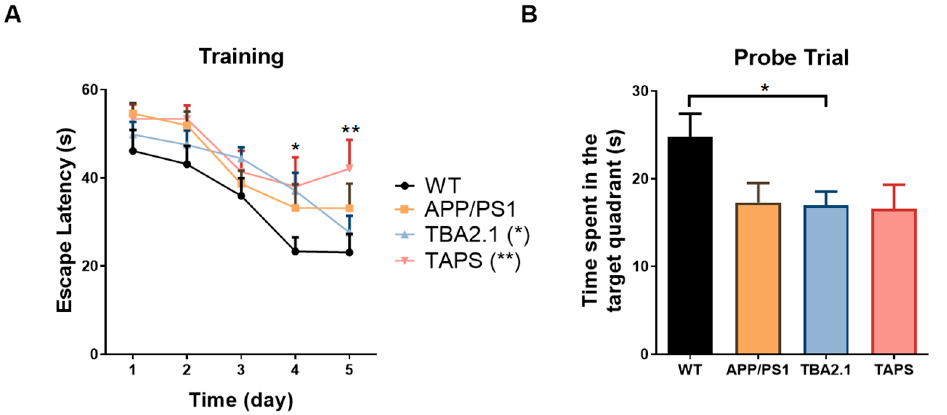
Figure 10. Performance in the Morris water maze with 20 months of age. In the training trials ( A ), the TAPS mice ( n = 6) took longer to find the hidden platform compared to the wild-type mice (WT; n = 11) on the last day (** p = 0.0087), as well as TBA2.1 ( n = 12) on the fourth day (* p = 0.0241), indicating a spatial learning deficit. In the probe trial ( B ), the TBA2.1 mice spent significantly less time in the target quadrant compared to WT mice (* p = 0.0319), while APP/PS1 ( n = 8) and TAPS mice showed a non-significant trend towards reduced memory retrieval as they spent less time in the target quadrant than the WT mice. For statistical analysis, two-way and one-way ANOVA with Dunnett´s post-hoc were used to compare the genotypes during the training and in the probe trial, respectively. Data are given as mean +